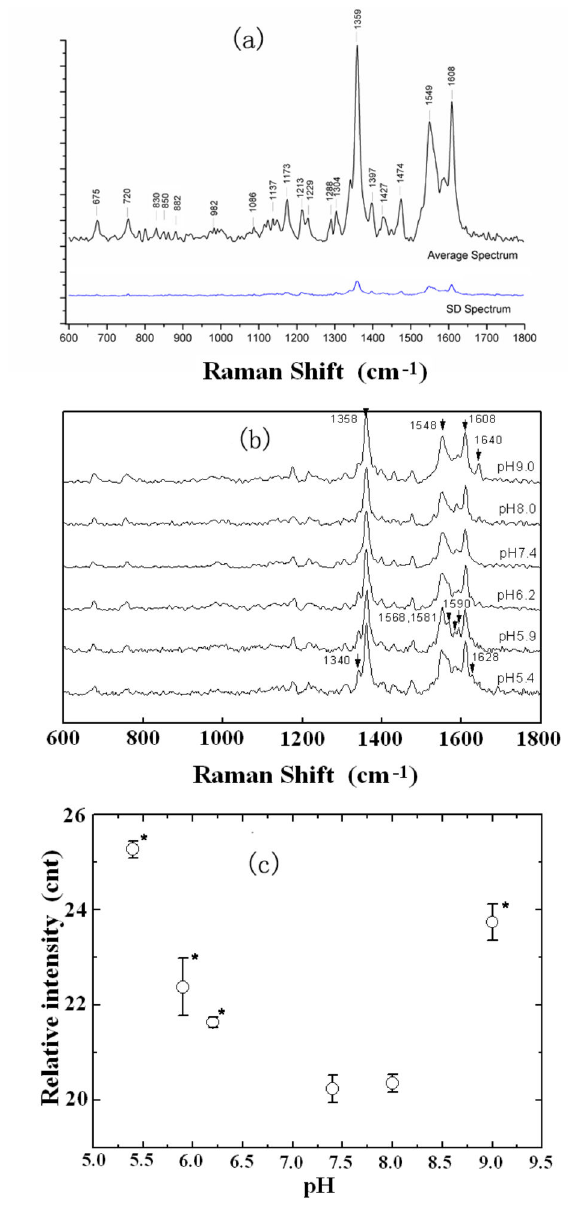
Figure 5. The enlarge images of the Raman spectra of human Hb in various pH conditions averaging from at least 25 spectra measured at each pH value. (a) The Tyr bands at 830cm -1 and 850cm -1 in solutions of pH 5.4, 7.4 and 9.0 respectively; (b) and (c): the secondary structure transforms in human hemoglobin at different pH levels indicated by enlarged Raman spectra. The 1247, 1253 and 1258 cm -1 bands are assigned to the random coil, while the 1265, 1273, 1277, 1280, 1286, 1288 and 1290 cm -1 bands are assigned to the α helix of the Amide III mode. doi: